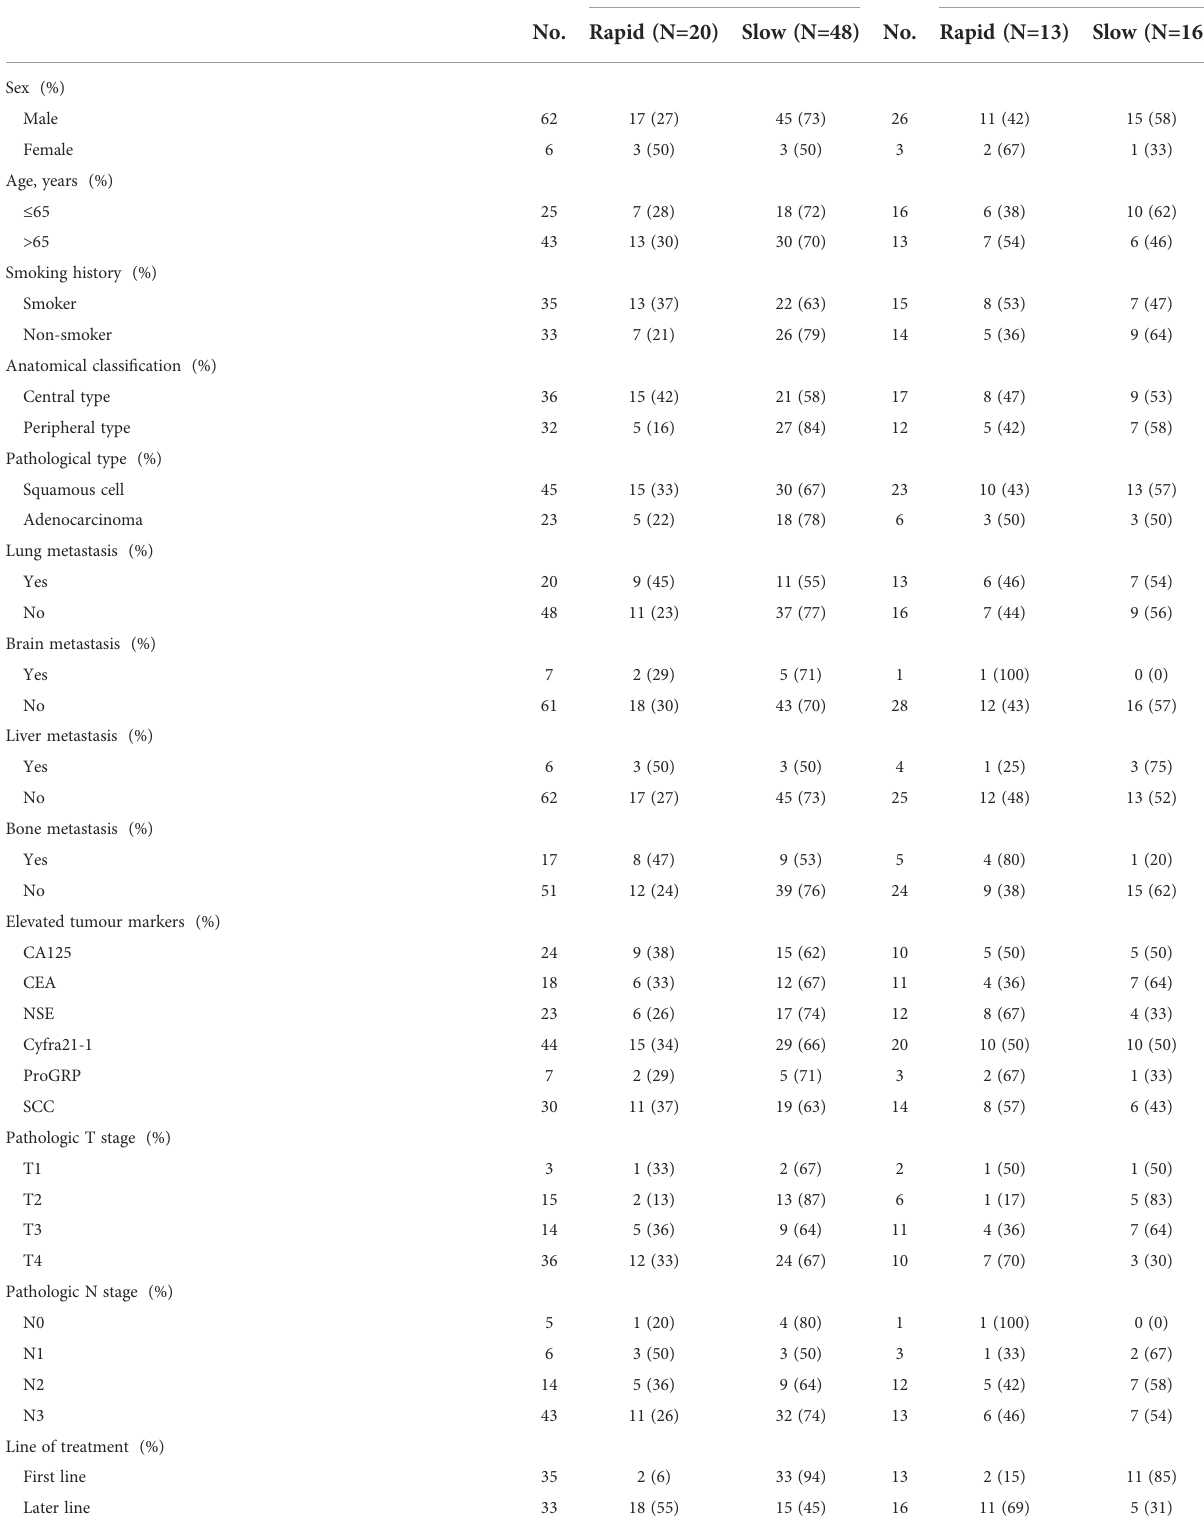
TABLE 1 Baseline data and PFS of the training and validation cohorts. Demographic or clinicopathologic characteristic,